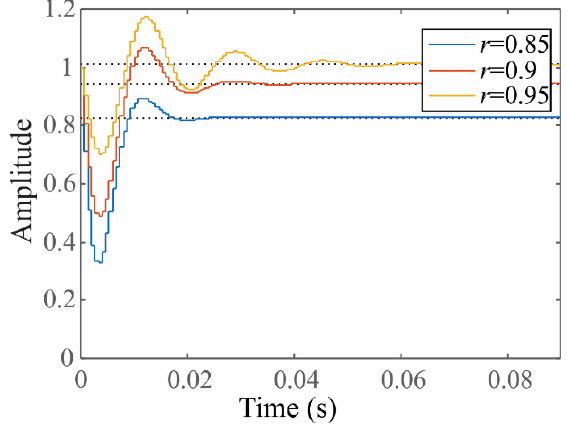
Figure 3. Notch filter response in the time domain for several r values.